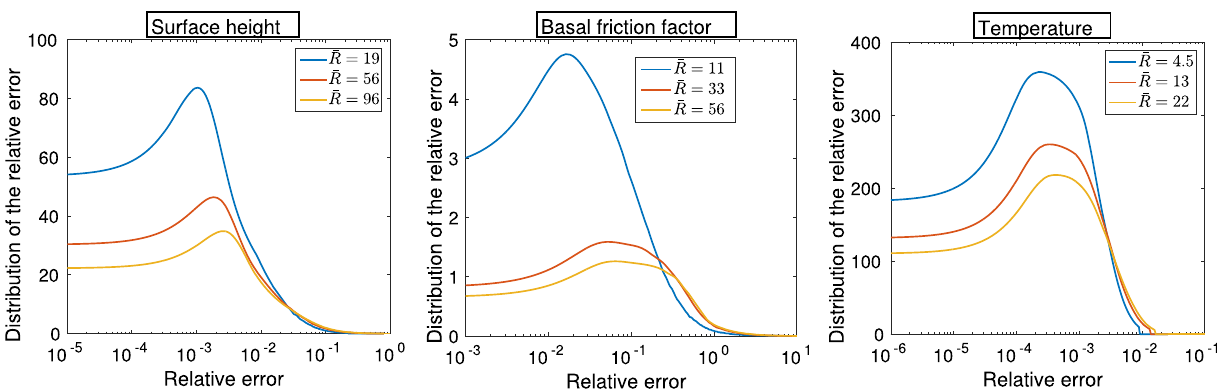
Fig. 20 Plots showing the probability density functions (PDF) of the relative error between the original and reconstructed versions of the indicated fields for different compression ratios. All the fields obtained from a Greenland ice sheet finite element simulation and